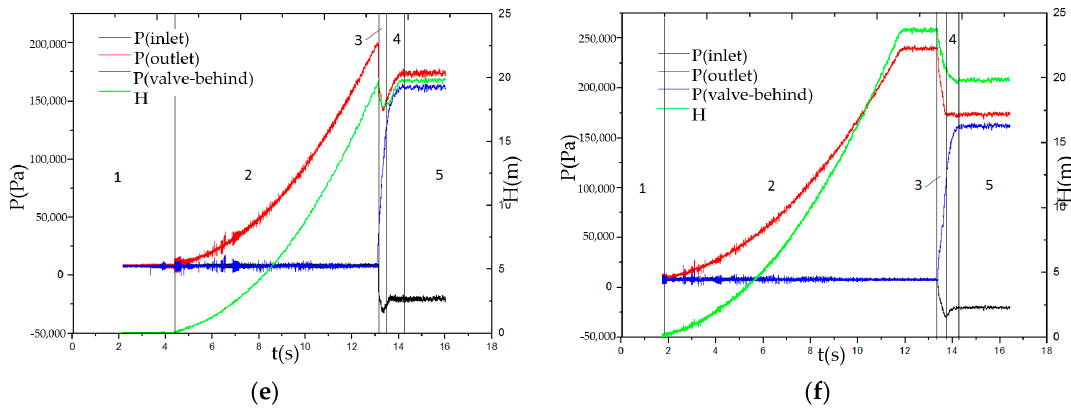
Figure 7. The inlet pressure, outlet pressure, and pressure behind the valve under different T c during the startup process; ( a ) T c = 0 s, ( b ) T c = 2.7 s, ( c ) T c = 4.2 s, ( d ); T c = 5.8 s, ( e ) T c = 7.8 s, ( f ) T c = 10.3 s.